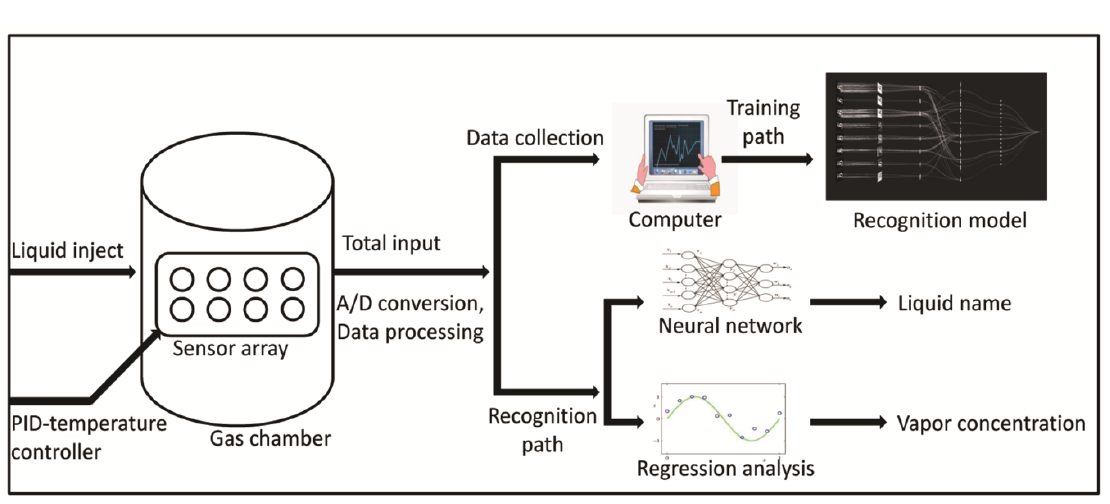
Figure 2. Working principle of the E-nose.